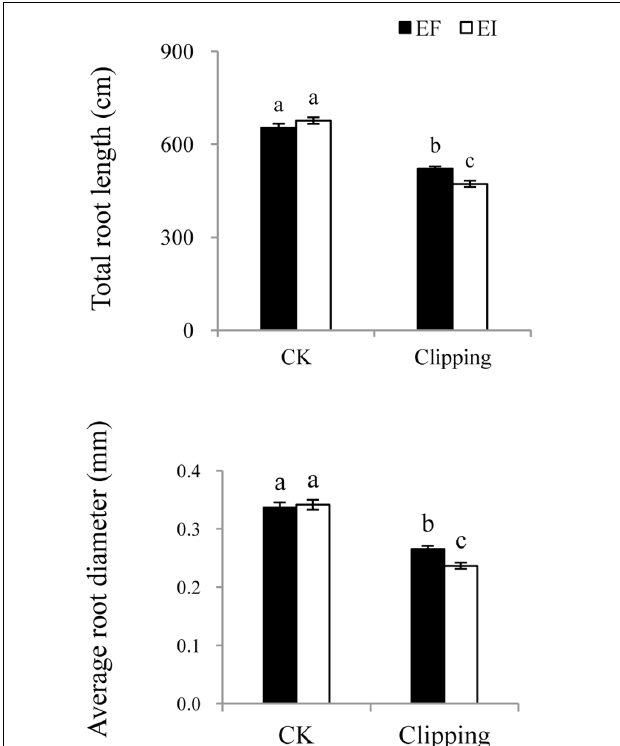
FIGURE 5 | Comparison of total root length and average root diameter of EF and EI A. sibiricum under unclipping (CK) and clipping treatments. Different lower-case letters denote means that are significantly different ( P < 0.05).